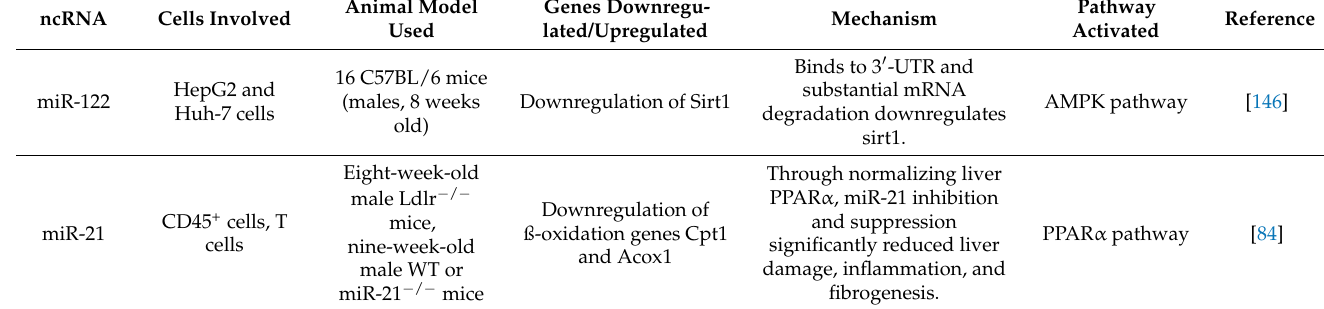
Table 1. Table showing the research studies completed on different miRNAs and lncRNAs and the underlying